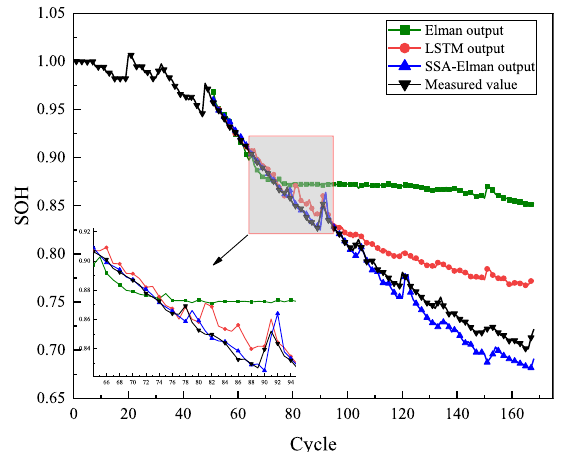
Fig. 14 The outputs of SSA-Elman, Elman and LSTM when using 30% training